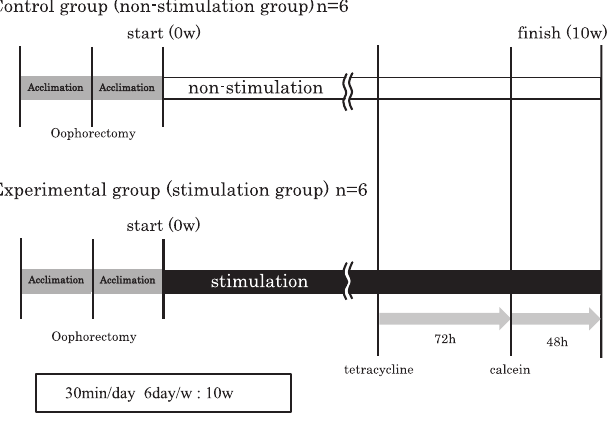
Figure 1 Experiment protocol Mice were divided into two groups of six: stimulation and non-stimulation (control). For the stimulation group, after 1 week of acclimatization from oophorectomy, we undertook stimulation once each day for 30 min, 6 days in a row, followed by 1 rest day for 10 consecutive weeks.